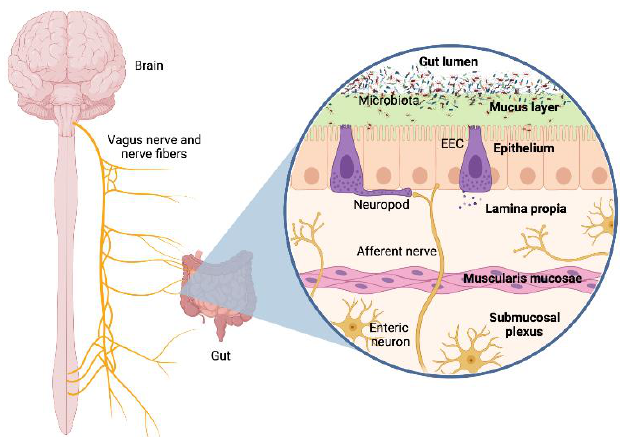
Figure 2. Scheme of the interaction between the microbiota and the vagus nerve.